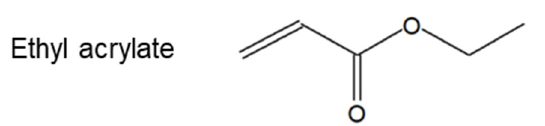
Figure 3. Analysis of photosensitive resin composition ( a ) Infrared spectrum of as-received photo- sensitive resin with band width assignment, ( b ) comparison between as-received and epoxy resin spectra, ( c ) testing experiments showing the setup with high-speed camera monitoring and rup- tured specimens for selected composites.